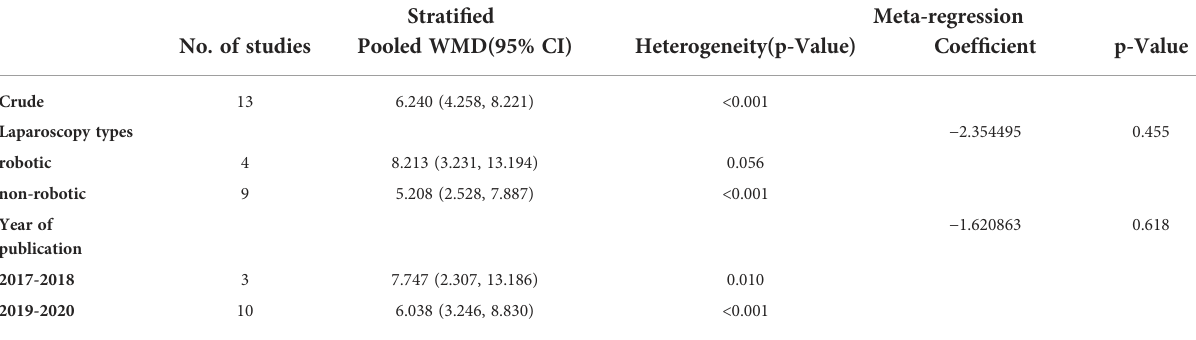
TABLE 2 Meta-regression and strati fi ed analysis of included studies related to laparoscopic gastrectomy with indocyanine